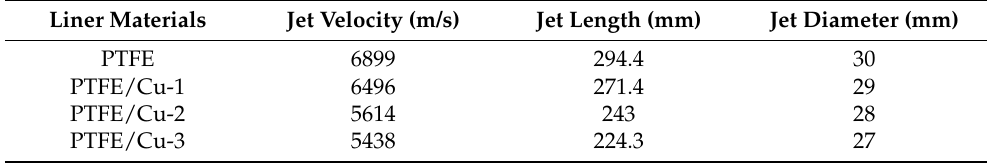
Table 5. Performance parameters of PTFE/Cu jet with different densities.